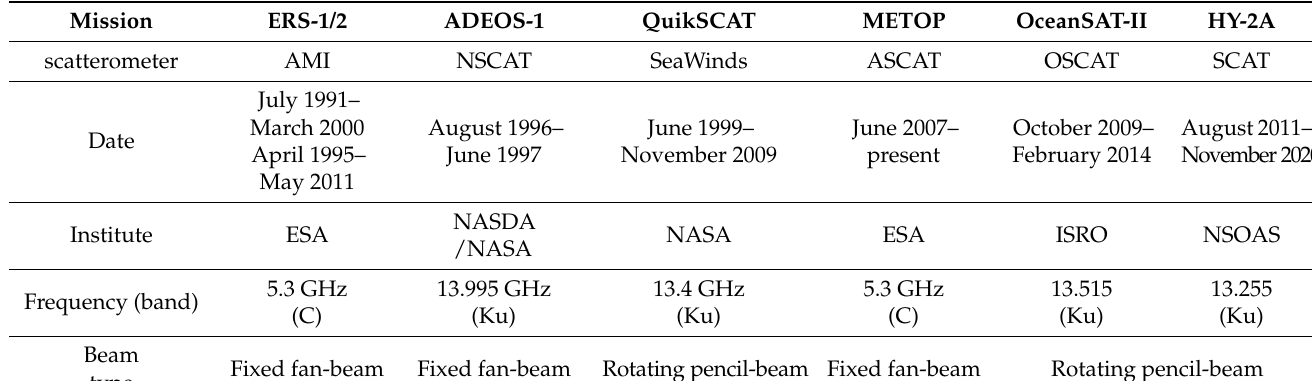
Table 1. Summary of spaceborne scatterometers and related sea ice